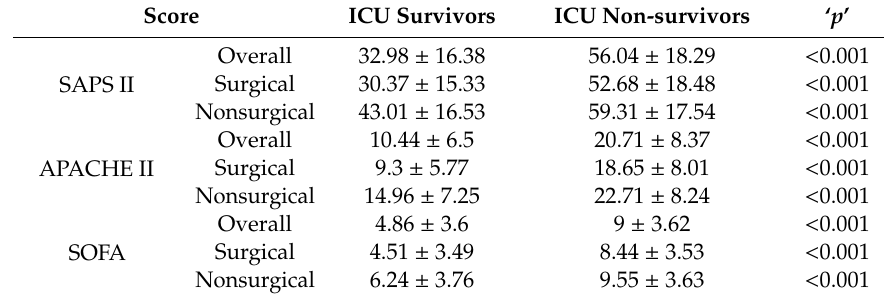
Table 2. SAPS II, APACHE II, and SOFA scores and intensive care unit (ICU) mortality.